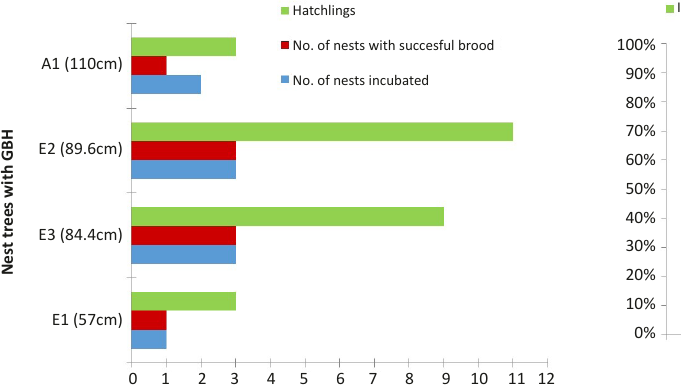
Figure 3. Sex-role in parental care during incubation till chicks venture out of